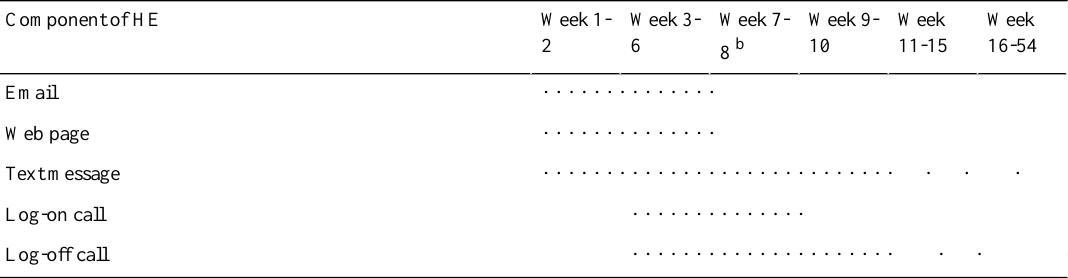
Table 1. Overview of potential contact points between HE and user during the entire intervention period